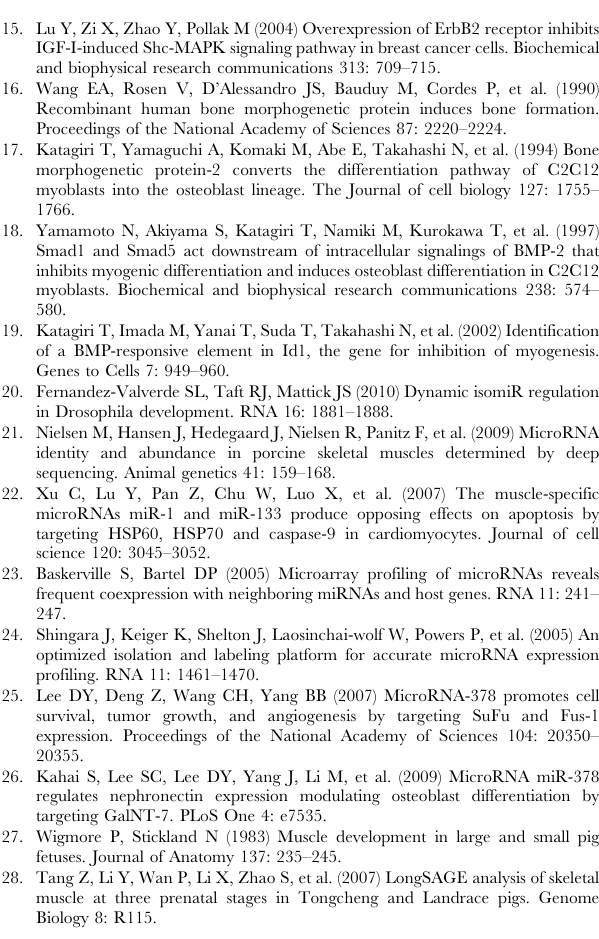
Table S2 Detail information of base edit in known miRNAs. Table S3 Predicted chromosomal positions and hairpin structures of novel miRNAs. Table S4 Rank of known mRNAs in solexa sequencing. Table S5 Primers for miRNA RT-qPCR. Table S6 Primers for luciferase reporter